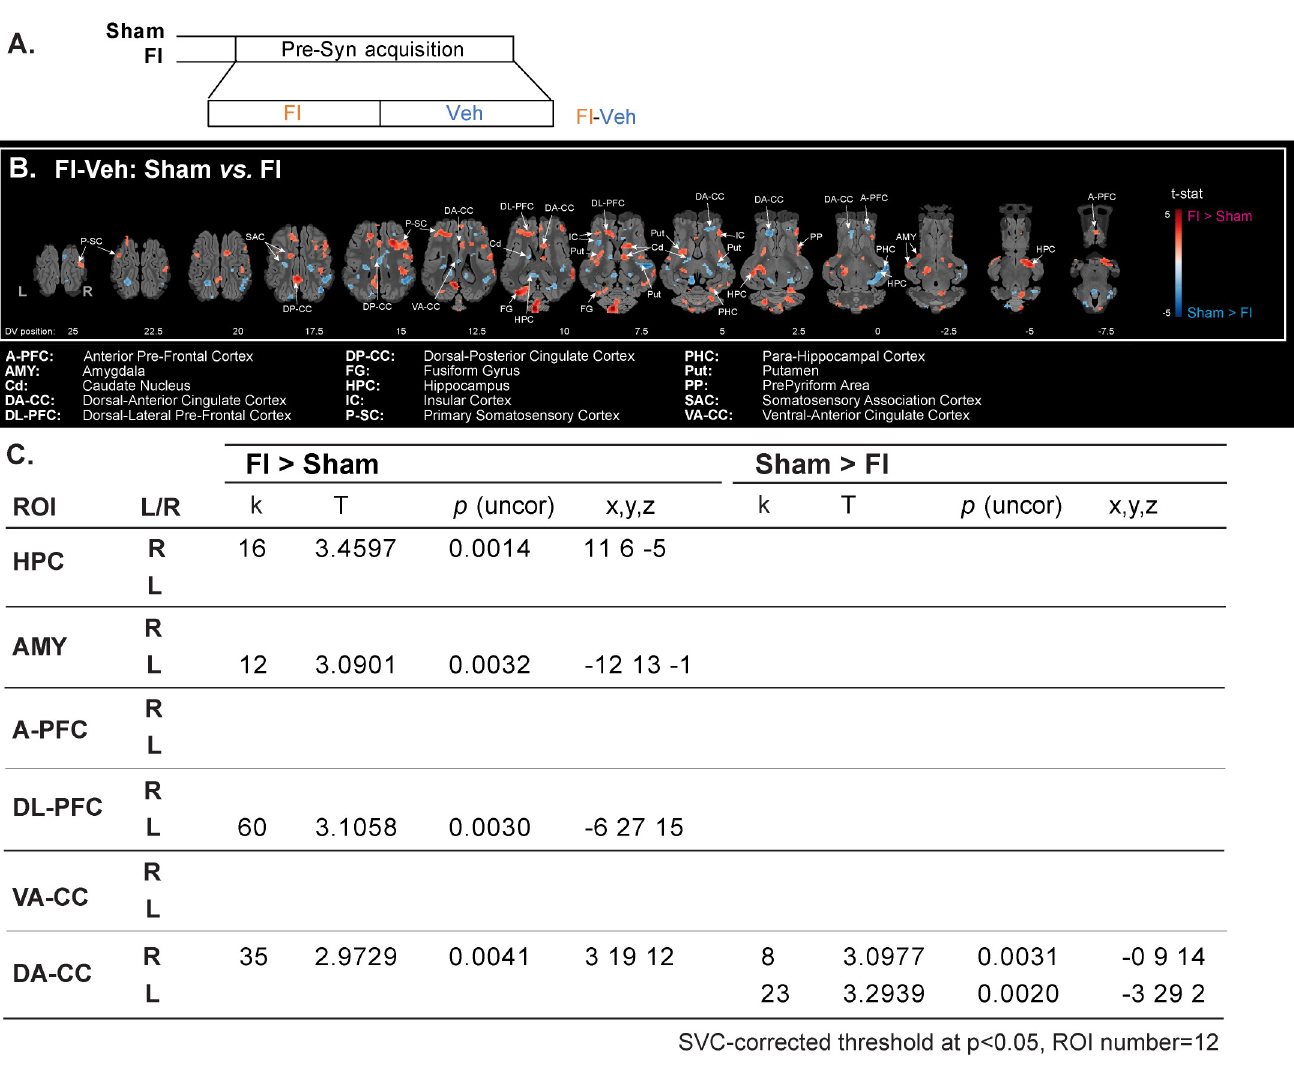
Fig 4. Previous supplementation increased the brain responses to an olfactory stimulation with the food ingredient. (A) Brain responses to the food ingredient were assessed in animals previously supplemented (FI, n = 10) or not (Sham, n = 10). FI: olfactory stimulation with the food ingredient, Veh: neutral stimulation with the vehicle. (B) Horizontal maps of brain BOLD responses to the food ingredient in both groups. p-value threshold = 0.05, k > 20, DV: dorsal-ventral position related to the posterior commissure (in mm). The part of the frontal cortices that was not covered with the average BOLD-based statistical maps is superimposed in dark grey on the anatomical maps. (C) SVC-based statistics: related regions of interest (ROIs) with uncorrected p-value that reached the criteria of p < 0.05 after Bonferroni